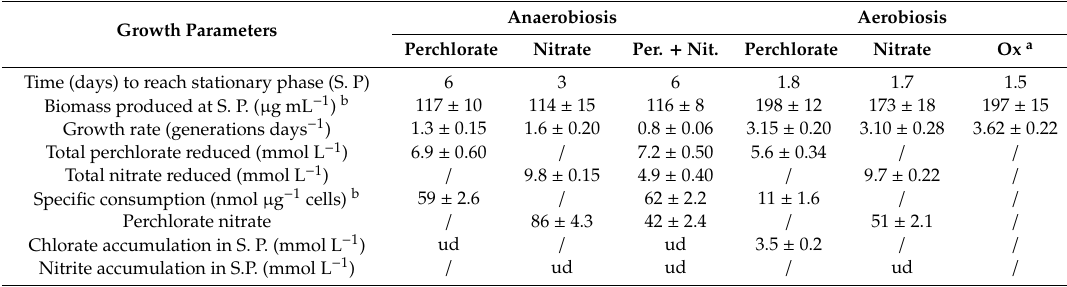
Table 1. Parameters of the growth calculated in VG modified medium with 10 mM acetate as carbon